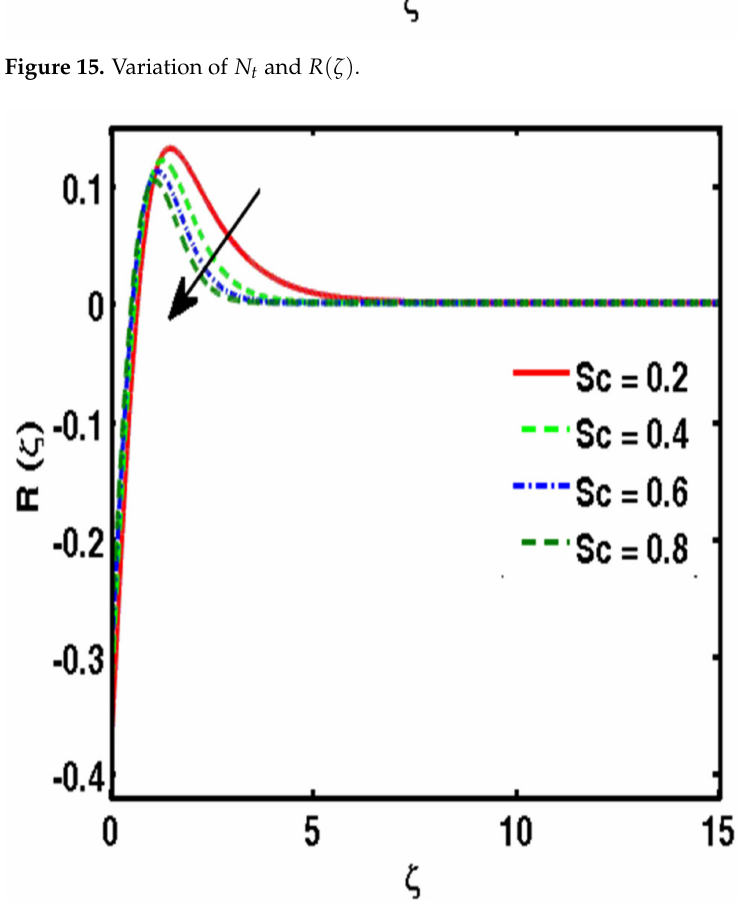
Figure 16. Description of the numerical